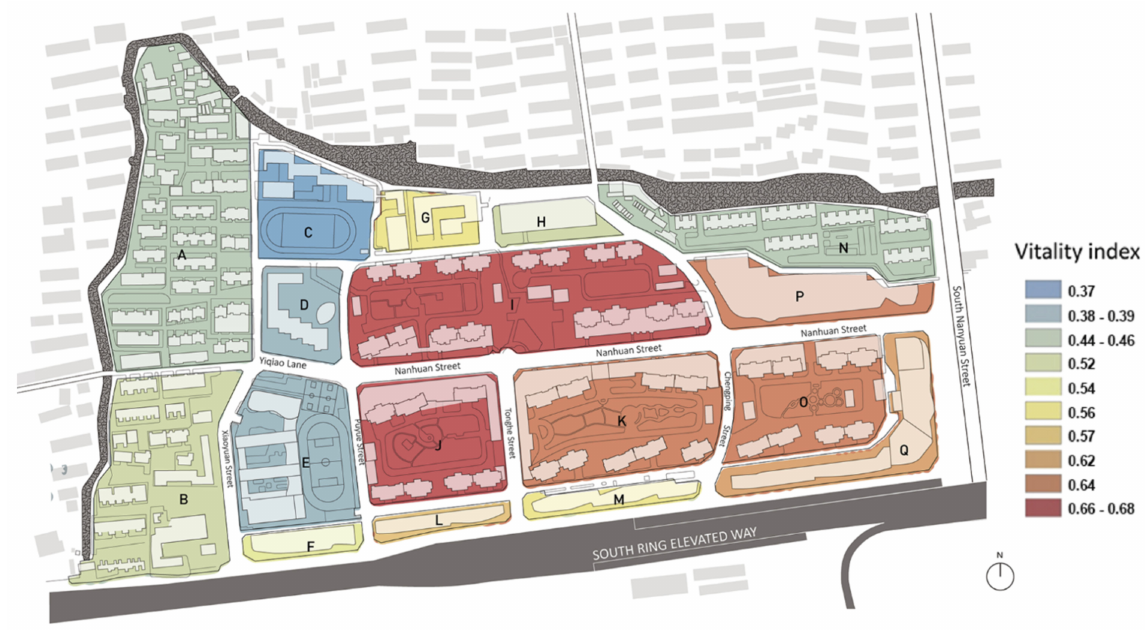
Figure 6. Distribution map of potential vitality in Nanhuan New Village.